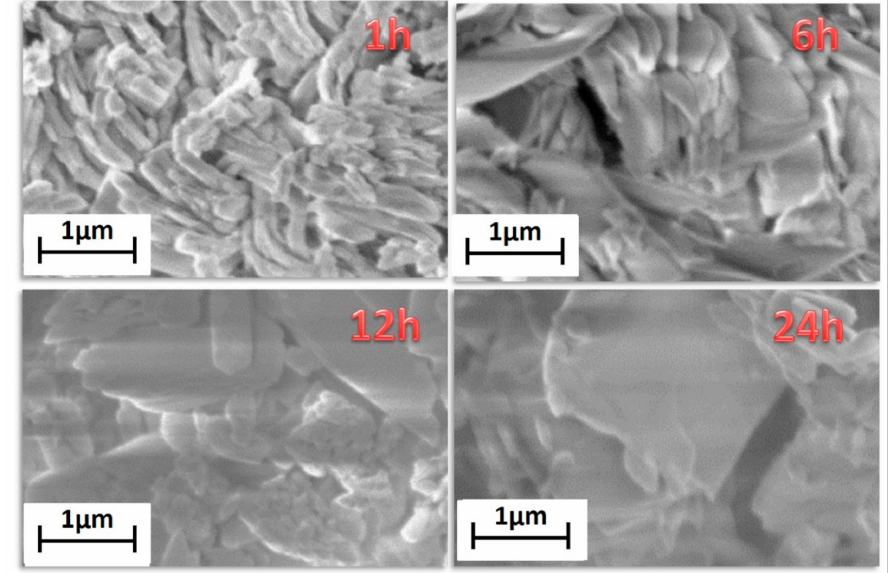
Figure 5. FE-SEM images of the [Gd 2 (NDC) 3 (H 2 O)] · 2(H 2 O) synthesized for 1 h, 6 h, 12 h and 24 h.